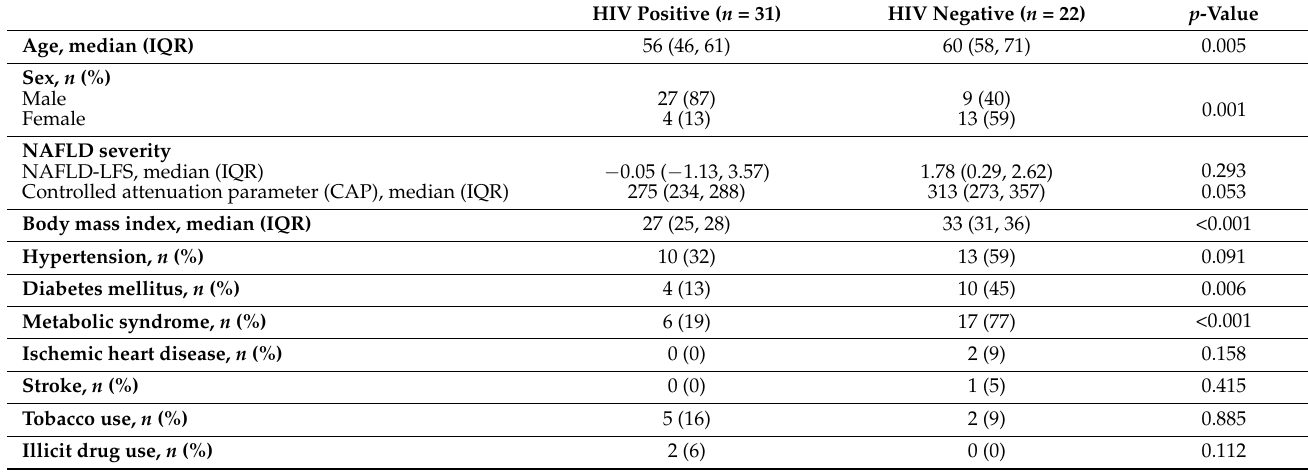
Table 1. Population baseline characteristics according to HIV Figure 1. Study flowchart. Participants were assessed for eligibility if they met the study’s analytical inclusion criteria and did not have a diagnosed alternative liver disease. * Alterative diagnoses were: